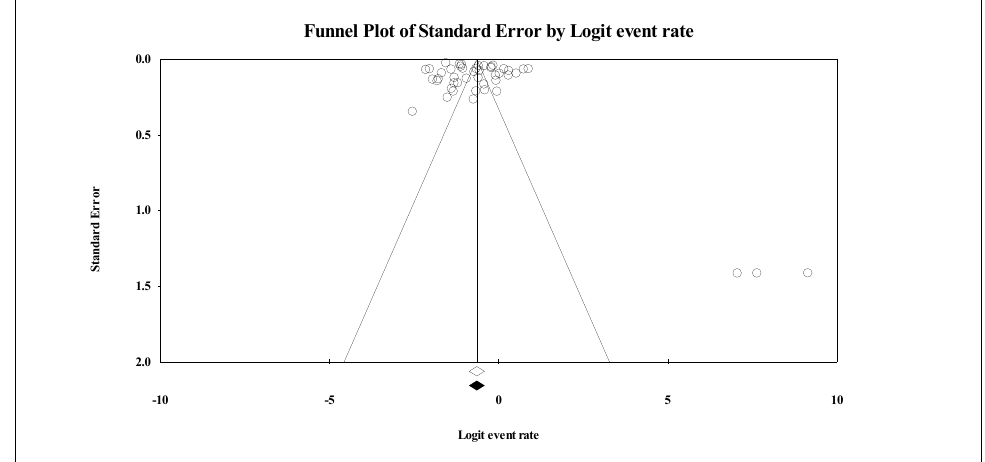
Figure A6. Funnel plot for studies on the prevalence of anxiety (Egger test: P = 0.15; Begg test: P = 0.90). The vertical solid line represents the summary effect estimates.